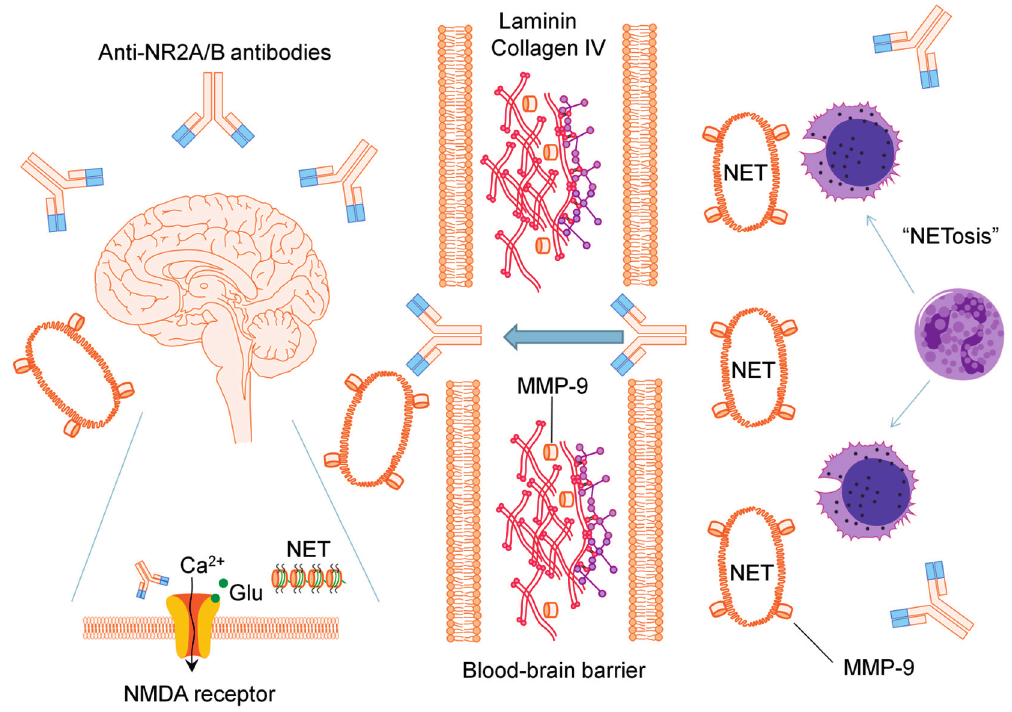
Figure 1. Proposed model of cognitive dysfunction in SLE. Abbreviations: NMDA, N -methyl- D -aspartate; MMP-9, matrix metalloproteinase-9; NET, neutrophil extracellular